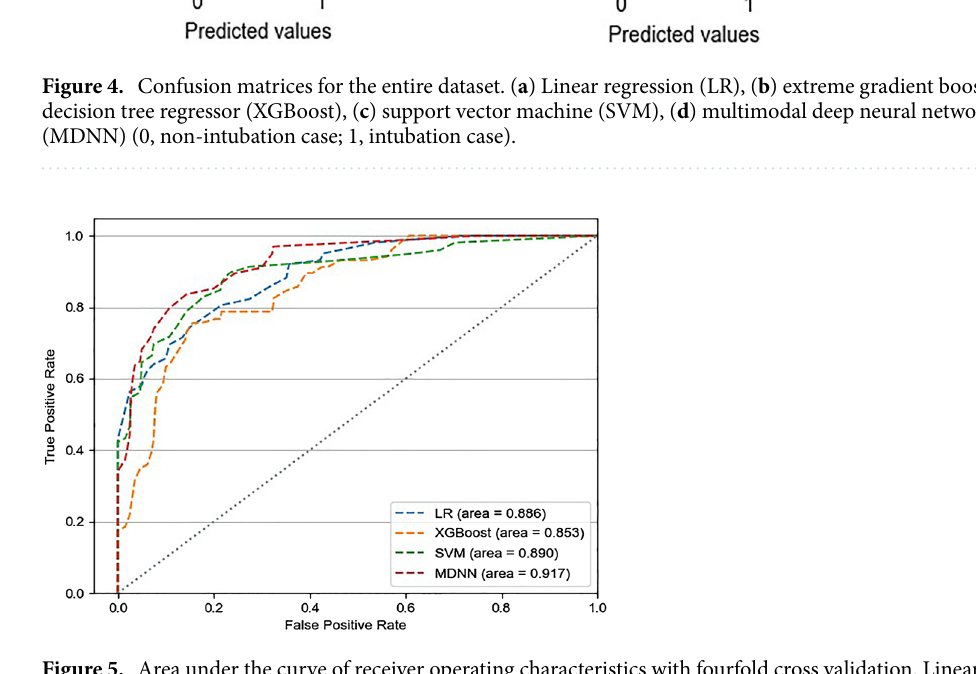
Figure 5. Area under the curve of receiver operating characteristics with fourfold cross validation. Linear regression (LR), extreme gradient boosting decision tree regressor (XGBoost), support vector machine (SVM), multimodal deep neural network